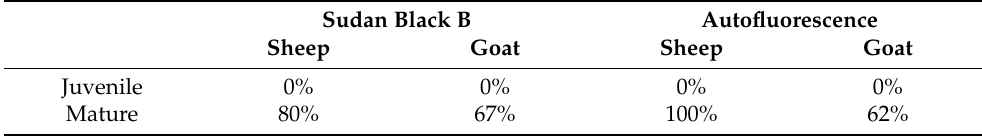
Figure 2. Identification of multinucleated giant cells in ovarian midsections. ( A )—Representative images of ovary midsections of sheep and goats stained with Sudan black B. ( B )—Representative images of ovarian autofluorescence. Ovarian autofluorescence is depicted in green and nuclear staining with DAPI in blue. ( C )—Characterization of multinucleated giant cells. Multinucleated giant cells show a light dark brown cytoplasm when stained with haematoxylin and eosin (black arrows), lipofuscin accumulation (positivity for Sudan black B and autofluorescence emission) and are often multinucleated (white arrowheads). Table 2. Percentage of ovaries positive for Sudan black B staining and